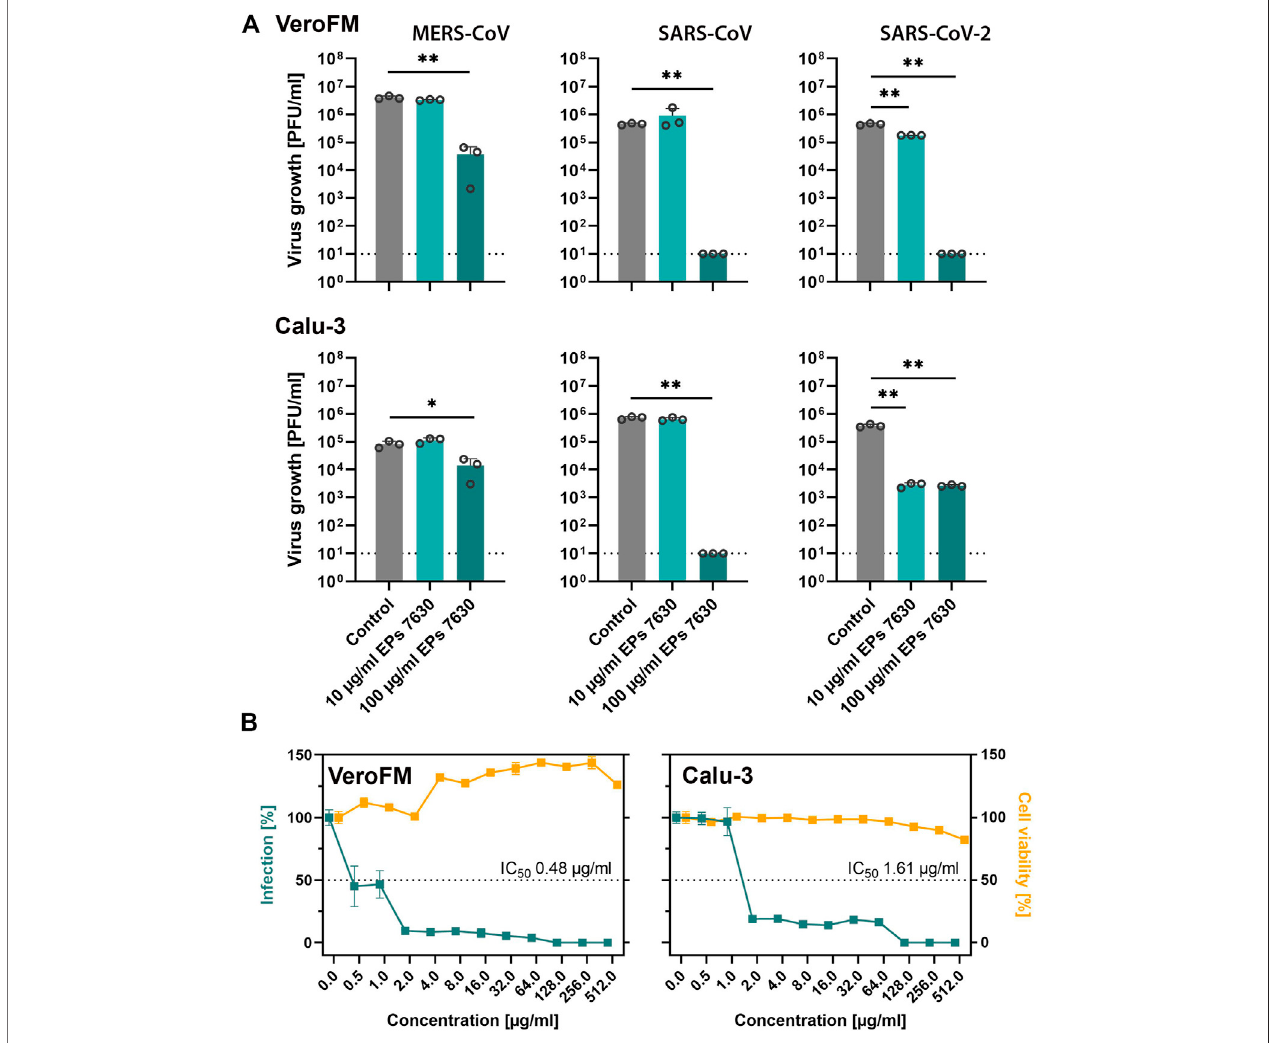
FIGURE1| EPs7630inhibitsthepropagationofhighlypathogeniccoronaviruses. (A) ComparisonofvirusgrowthofSARS-CoV,MERS-CoV,andSARS-CoV-2in VeroFM and Calu-3 cells using an MOI of 0.0005 and indicated concentrations of EPs 7630. Virus-containing supernatants were collected 48 h post-infection and viral titers were determined as plaque-forming units (PFU)/ml by plaque titration assay. Bars represent mean values and SD from n (cid:2) 3 biological samples. Statistical signi fi cance(treatmentvscontrol)isindicatedby(*)asdeterminedbyunpaired t -testwithWelch´scorrection.(*) (cid:2) p < 0.05;(**) (cid:2) p < 0.01.Control (cid:2) mediumonly. (B) SARS-CoV-2IC50determination (plaquetitration)and cellviabilityassay(CellTiter Glo2.0)inVeroFMand Calu-3cellsat48 hpost-treatment/-infection.Dataareshown as percent of untreated cells and represent mean values from at least n (cid:2) 3 biological samples.